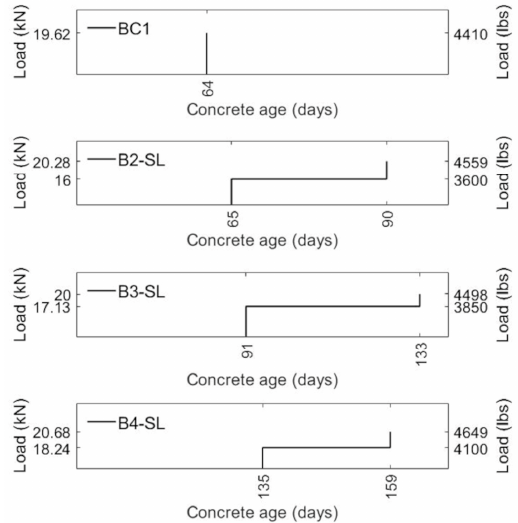
Figure 7. Beam series I loading histories.